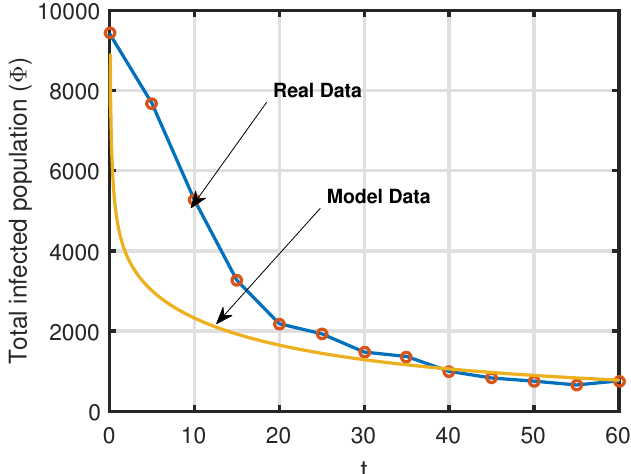
Figure 2. Real Data vs. Model Data of total infected ( I + C ) cases between 1 June 2021 and 31 July